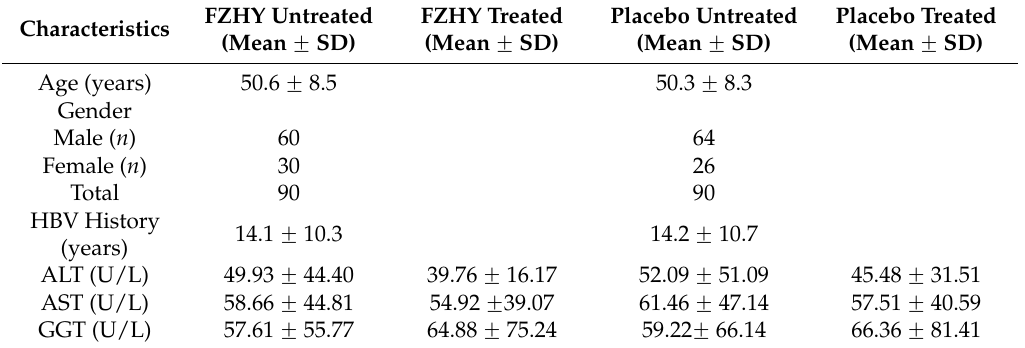
Table 2. Clinical data of subjects a